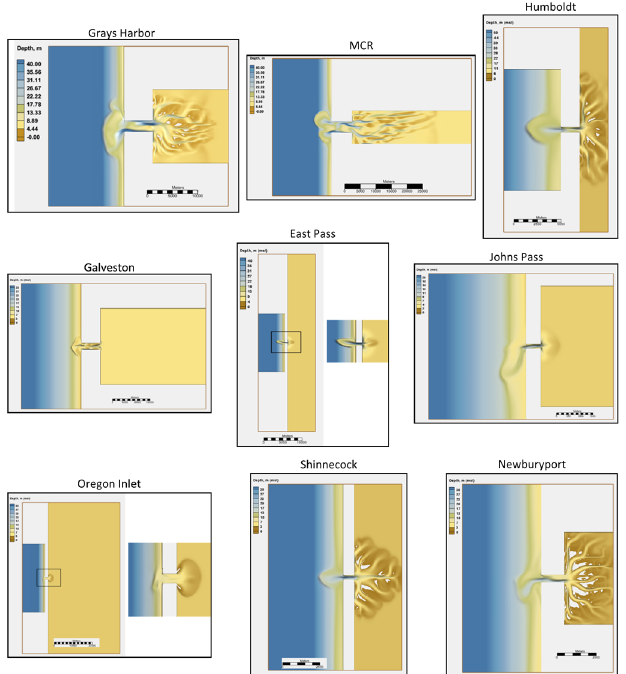
Figure 4. Final bed morphology. The top three inlets are along the West Coast of the United States, the middle three inlets are along the Gulf Coast, and the bottom three inlets are along the Eastern Coast. White areas shown inside the bays denote areas that were considered dry (above the water level) at the end of the simulation. For clarity, color scale and map legend vary between inlets.